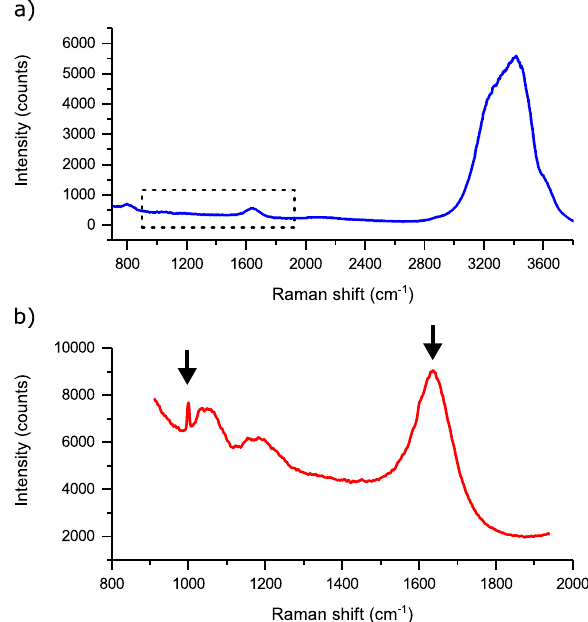
Figure 5. Fiber-enhanced Raman spectra of polystyrene nanoparticles in aqueous solution. ( a ) Full-spectrum showing Raman scattering originating from water and silica in the fiber, dominated by scattering from the O–H stretching mode of water molecules. The spectrum is the average of two acquisitions, with an integration time of five seconds each, and a laser excitation power of 1.7 mW. A second measurement was made as shown in ( b ) with arrows denoting the peaks arising from polystyrene and water. The spectrum has limits as shown by the dotted box in Figure 5a and is the average of ten acquisitions, with an integration time of ten seconds each, and a laser excitation power of 50 mW. The peaks around 1050 cm − 1 and 1200 cm − 1 are caused by the silica walls of the hollow-core photonic crystal fiber